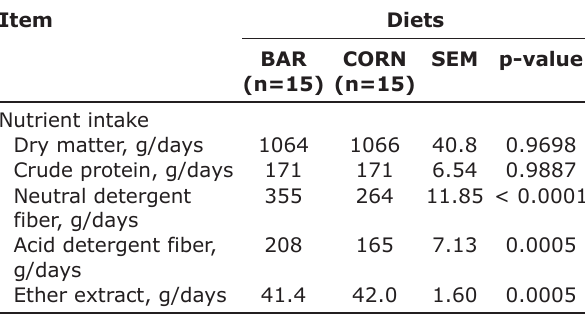
Table-2: Effects of feeding either BAR or CORN grains on nutrient intakes of growing Awassi lambs. Item Diets